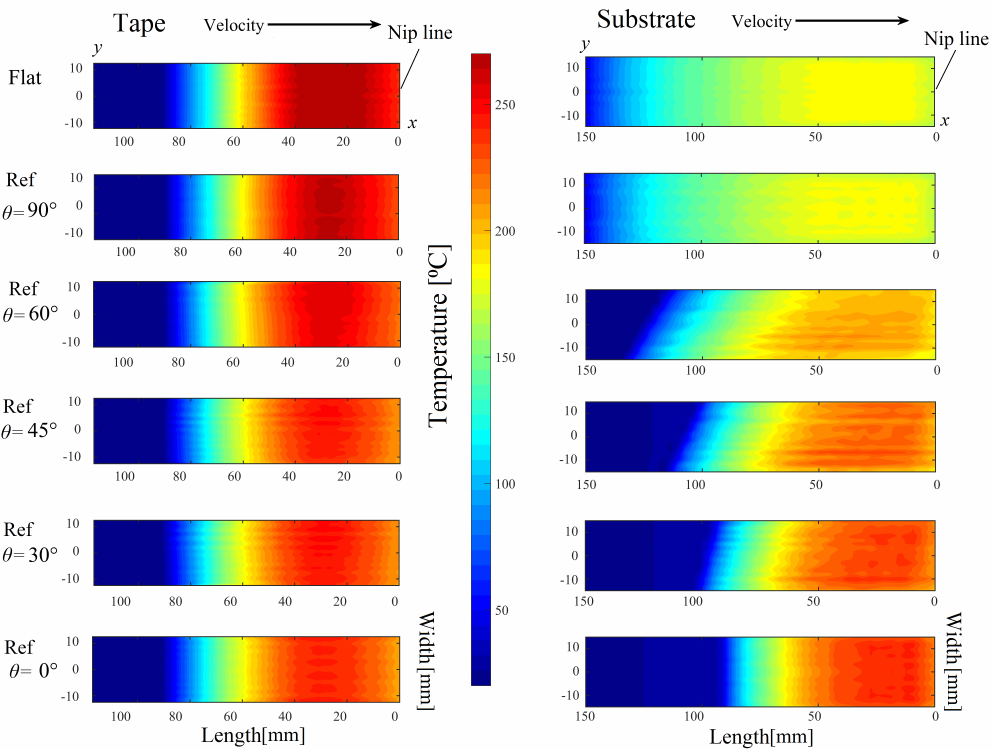
Figure 14. The distribution of the total absorbed power based on the incoming and reflected rays of ( a ) substrate and ( b ) tape for case Ref and Flat with different θ .